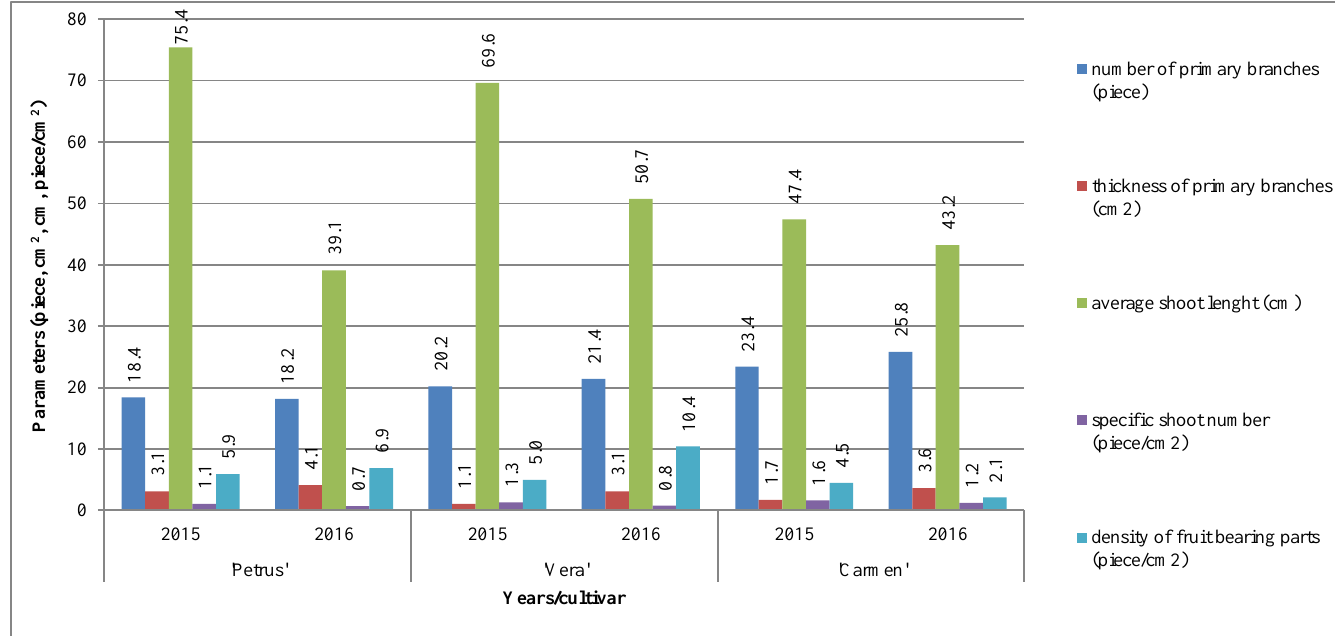
highest ramification ability.